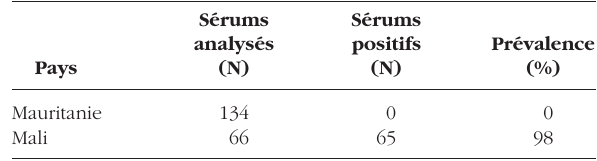
Tableau I. – Taux de séroprévalence de la cowdriose chez le zébu maure aux abattoirs de